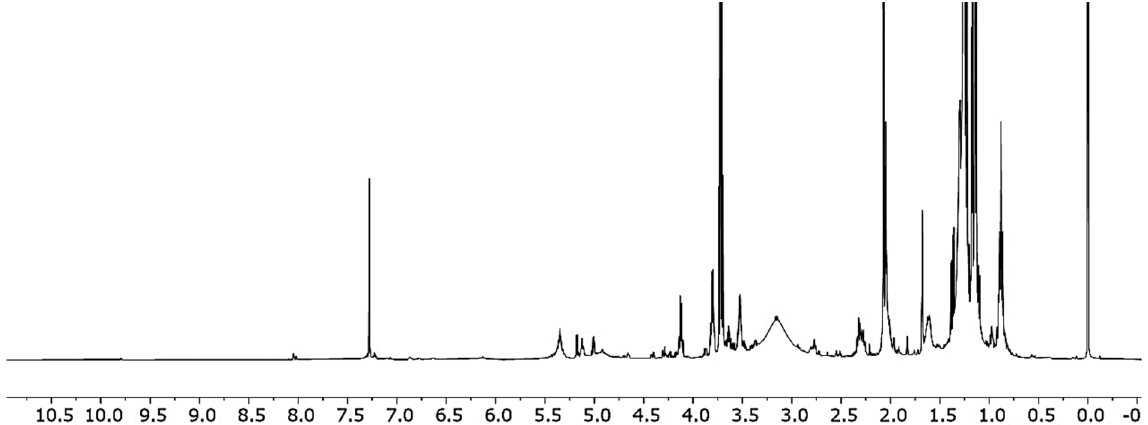
Figure 1. 1 H nuclear magnetic resonance (NMR) of diethyl ether extracts of saffron stamens (CDCl 3 ).